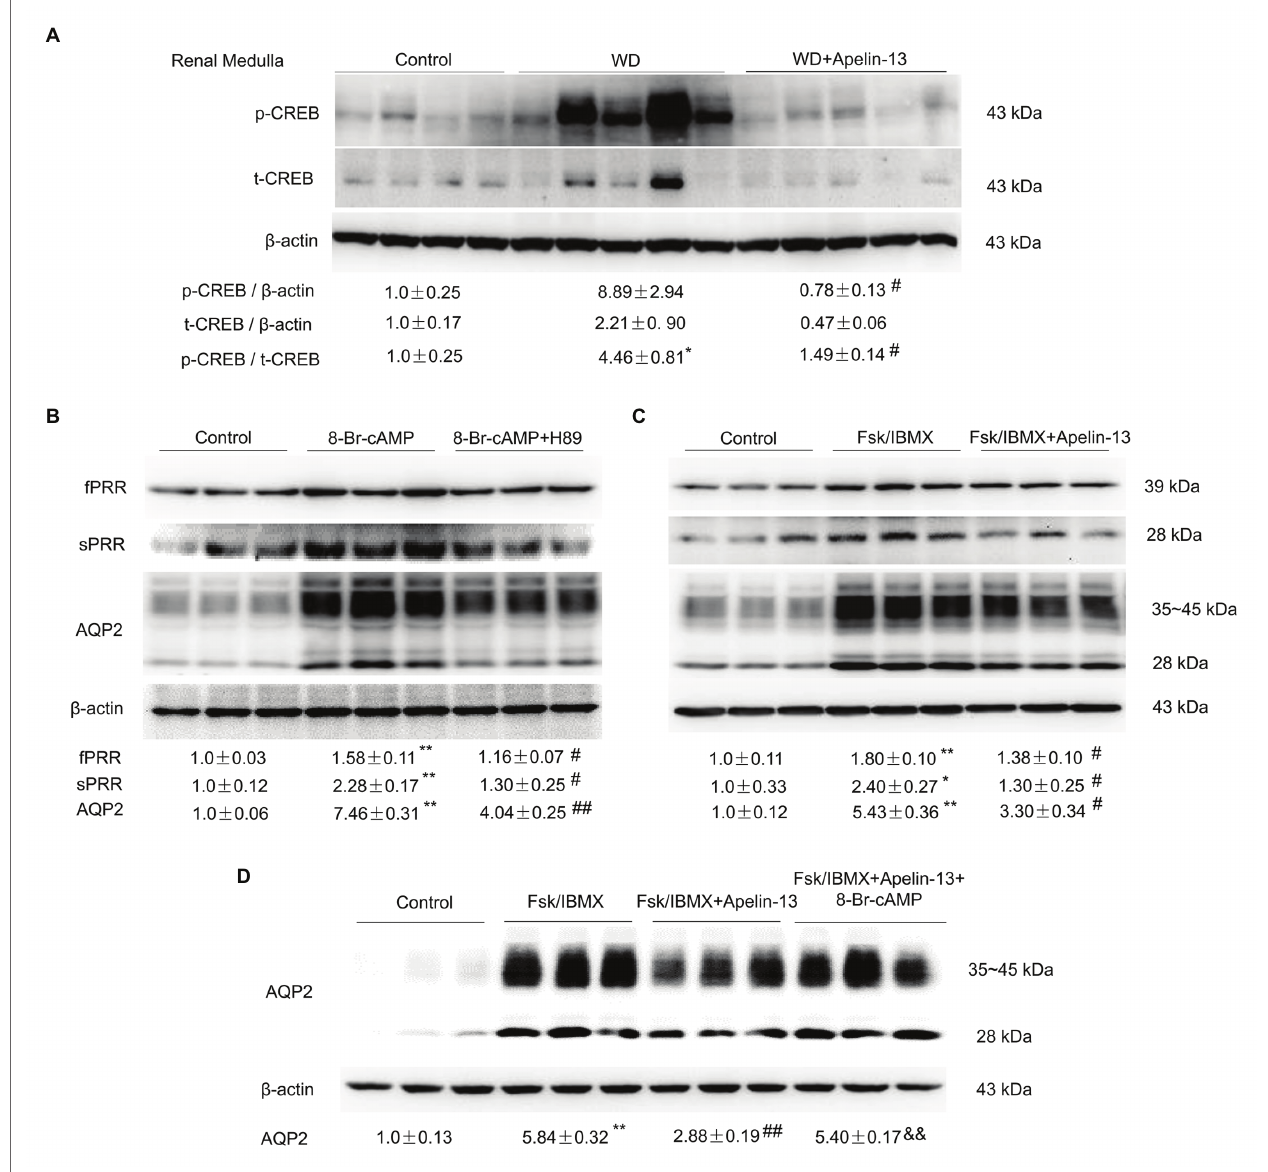
FIGURE 5 | Apelin-13 regulates PRR and AQP2 via the cyclic adenosine monophosphate (cAMP)-protein kinase A (PKA) signaling pathway. (A) Representative immunoblotting and densitometric analysis of kidney medullary p-CREB (Ser133) and CREB protein expression in the WD mice, β -actin as an internal control for equal loading of the samples. n = 4–5 per group. Data are mean ± SEM. * p < 0.05 vs. Control, # p < 0.05 vs. WD. (B) Effect of cAMP/PKA pathway on PRR and AQP2 expression in the primary rat inner medullary collecting duct (IMCD) cells. Cells were pretreated with H89 and then treated with 100 μ M 8-Br-cAMP for 24 h. The expression of PRR and AQP2 protein was analyzed by immunoblotting and normalized by β -actin. n = 3 per group, repeat three times. Data are mean ± SEM. ** p < 0.01 vs. Control; # p < 0.05 and ## p < 0.01 vs. 8-Br-cAMP. (C) Effect of apelin-13 on PRR and AQP2 expression in forskolin (FSK)/3-Isobutyl-1-methylxanthine (IBMX)-treated IMCD cells. Cells were pretreated with 100 nM apelin-13 and then treated with FSK (10 μ M)/IBMX (100 μ M) for 24 h. The expression of PRR and AQP2 protein was analyzed by immunoblotting and normalized by β -actin. n = 3 per group, repeat three times. Data are mean ± SEM. * p < 0.05 and ** p < 0.01 vs. Control; # p < 0.05 vs. FSK/IBMX. (D) Effect of cAMP on AQP2 protein expression in FSK/IBMX + apelin-13-treated IMCD cells. Cells were pretreated with 100 nM apelin-13, or in combination with 100 μ M 8-Br-cAMP, then treated with FSK (10 μ M)/IBMX (100 μ M) for 24 h. The expression of AQP2 protein was analyzed by immunoblotting and normalized by β -actin. n = 3 per group. Data are mean ± SEM. ** p < 0.01 vs. Control; ## p < 0.01 vs. FSK/IBMX, && p < 0.01 vs. FSK/IBMX +